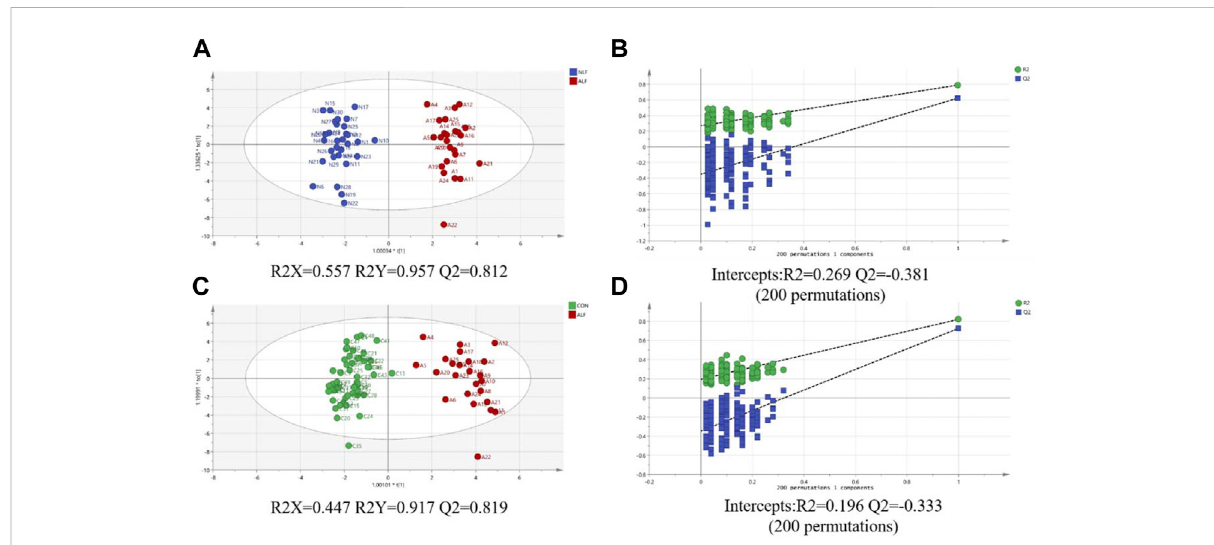
FIGURE 3 (A) Score plot of the OPLS-DA model between ALF and NLF groups; (B) Cross-validation plot of OPLS-DA mode with 200 times permutation tests betweenALF and NLFgroups; (C) core plotof theOPLS-DA model between ALFand CON groups; (D) Cross-validation plotof OPLS-DA mode with 200 times permutation tests between ALF and CON groups.